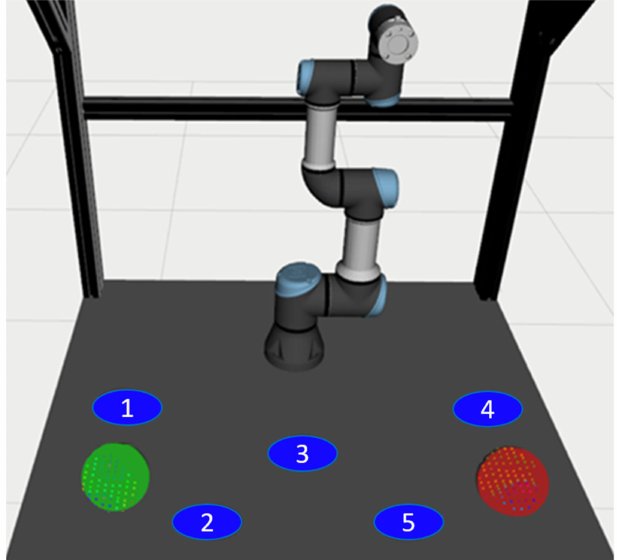
Figure 13. Preview of the workplace and the robot’s goal positions (marked with numbers 1–5); hand positions are marked with red ( right hand ) and green ( left hand ); the robot is in the initial